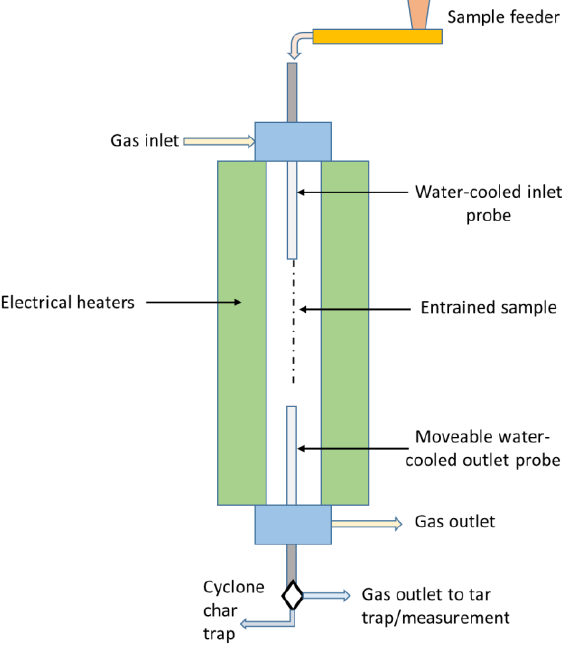
Figure 4. Schematic of drop tube furnace.